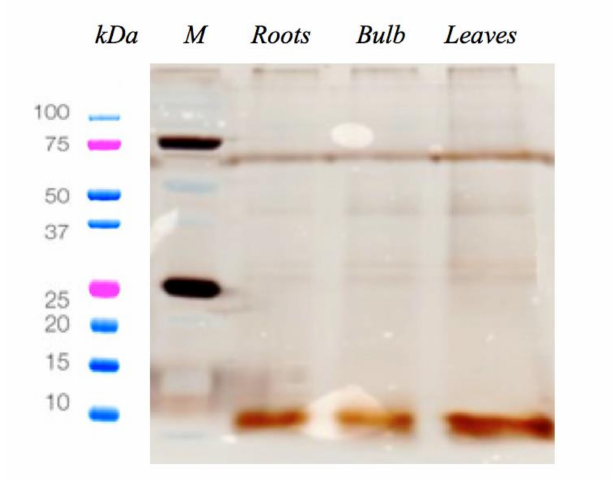
Figure 1. Silver staining of total acid extract from C. pancration after SDS- PAGE. (Line M, Molecular Weight Standards; line Roots, Proteins extracted from test plant roots; line Bulb, Proteins extracted from test plant bulb; line Leaves, Proteins extracted from test plant leaves).